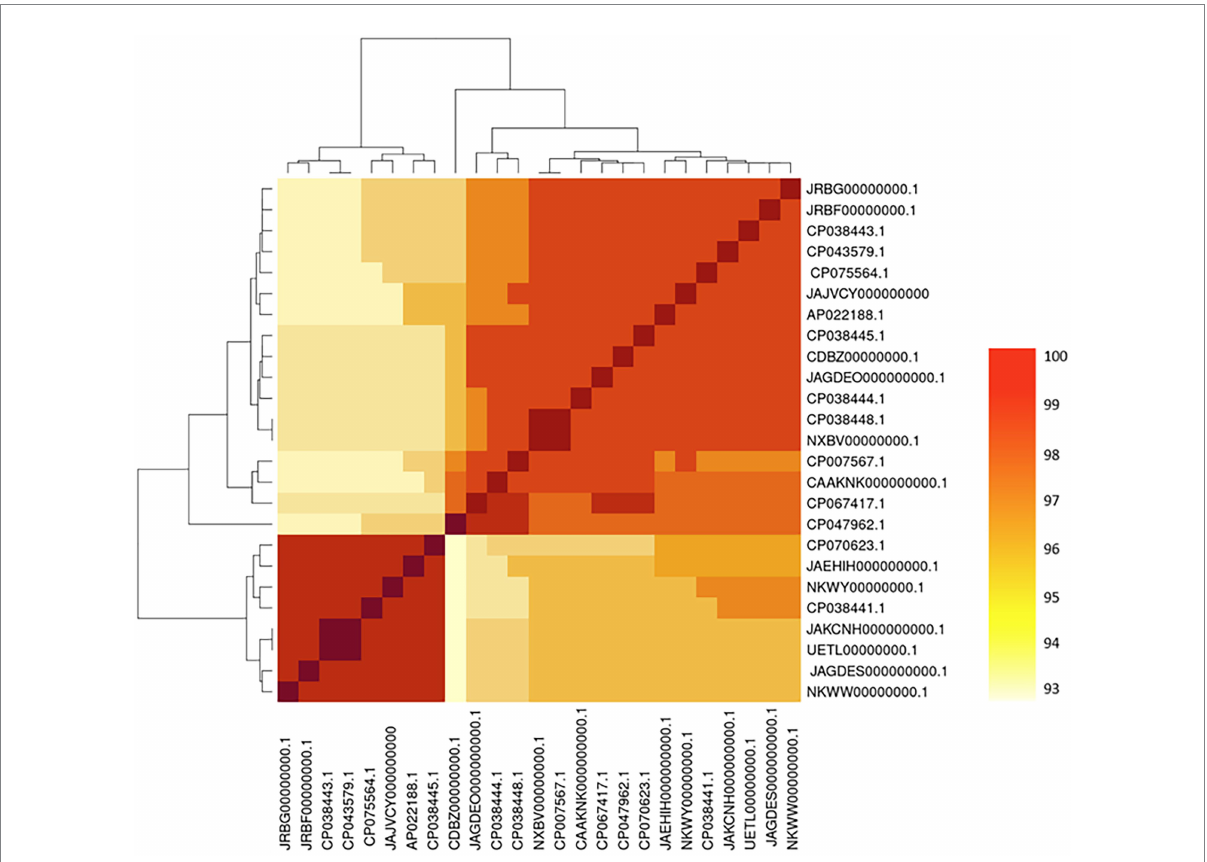
FIGURE 2 Heatmap/cladogram combined with phylogenetic comparison of Aeromonas media strain SD/21–15 isolated from an aquatic environment in Denmark with other strains retrieved from the National Center for Biotechnology Information (NCBI) public databank isolated from different host species and environments in the world. Note the high similarity among all 25 A . media strains with homology varying between 93 and